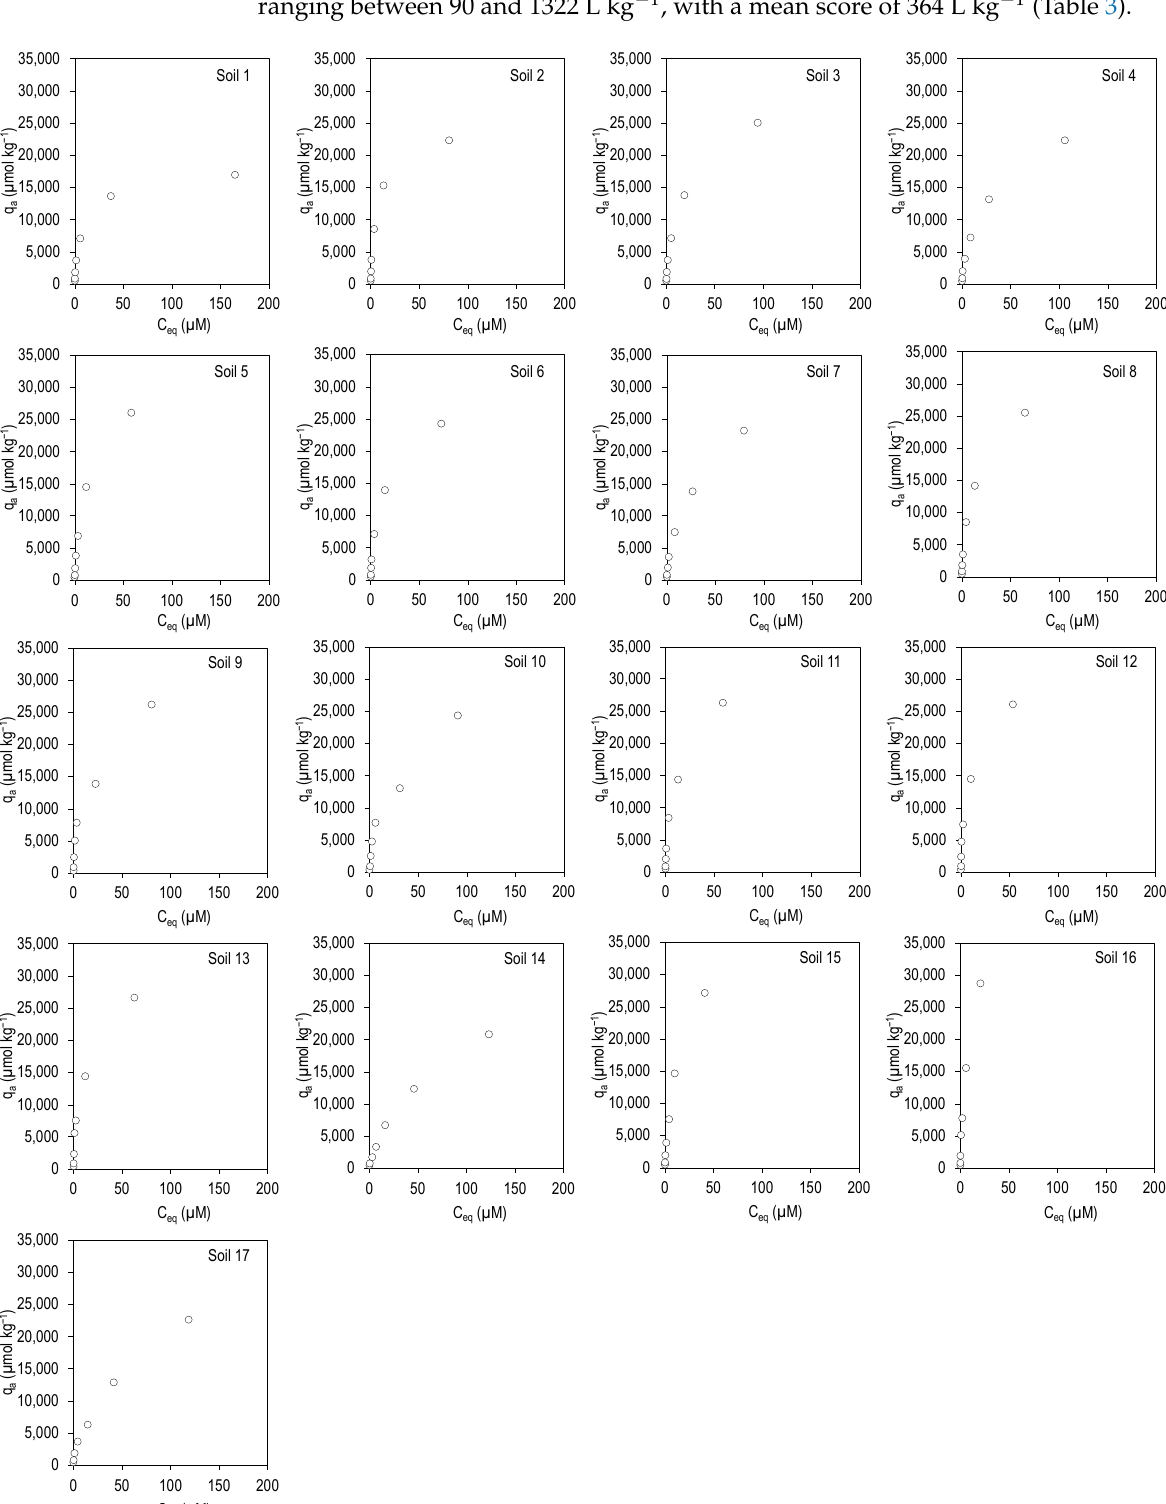
Figure 1. Adsorption curves for CIP in the 17 soils studied. q a : CIP adsorbed onto the soil; C eq : CIP concentration in the equilibrium solution. Average values ( n = 3), with coefficients of variation always lower than 5%.